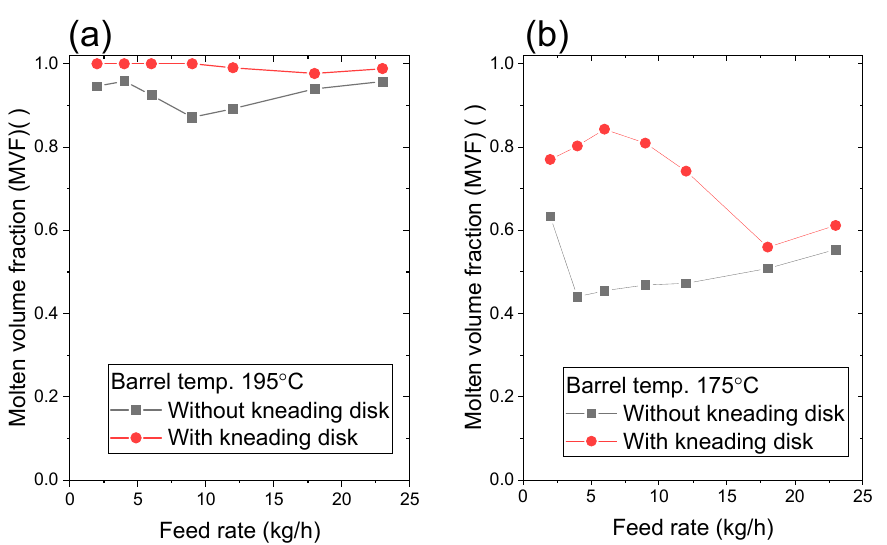
Figure 10. Effect of kneading disk on the molten volume fraction (MVF). The screw rotation speed is 150 rpm. The barrel temperatures were ( a ) 195 ◦ C and ( b ) 175 ◦ C, respectively. The screw configuration of “with kneading disk” was (C) and that of “without kneading disk” was (B).